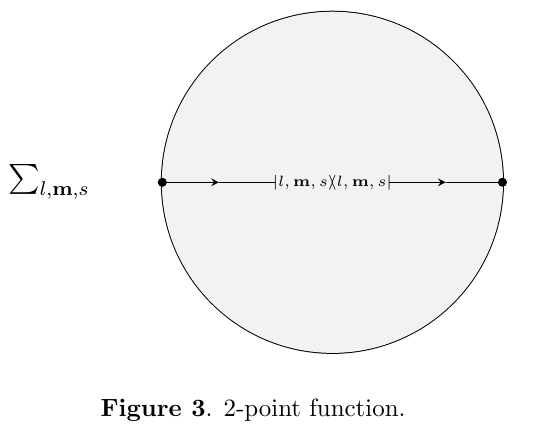
Figure 3 . 2-point